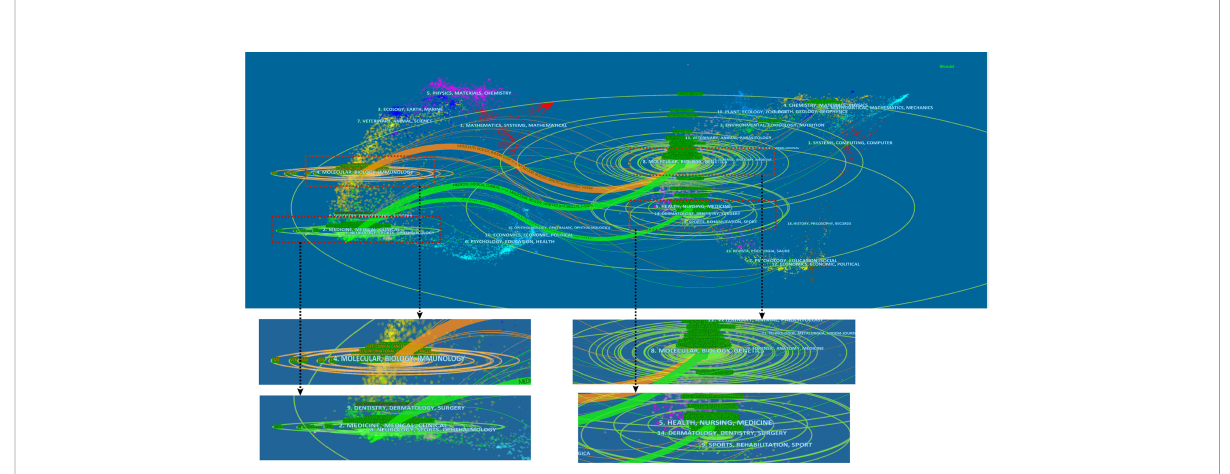
FIGURE 6 A dual-map overlay of the relevant journals generated by CiteSpace V (version5.8